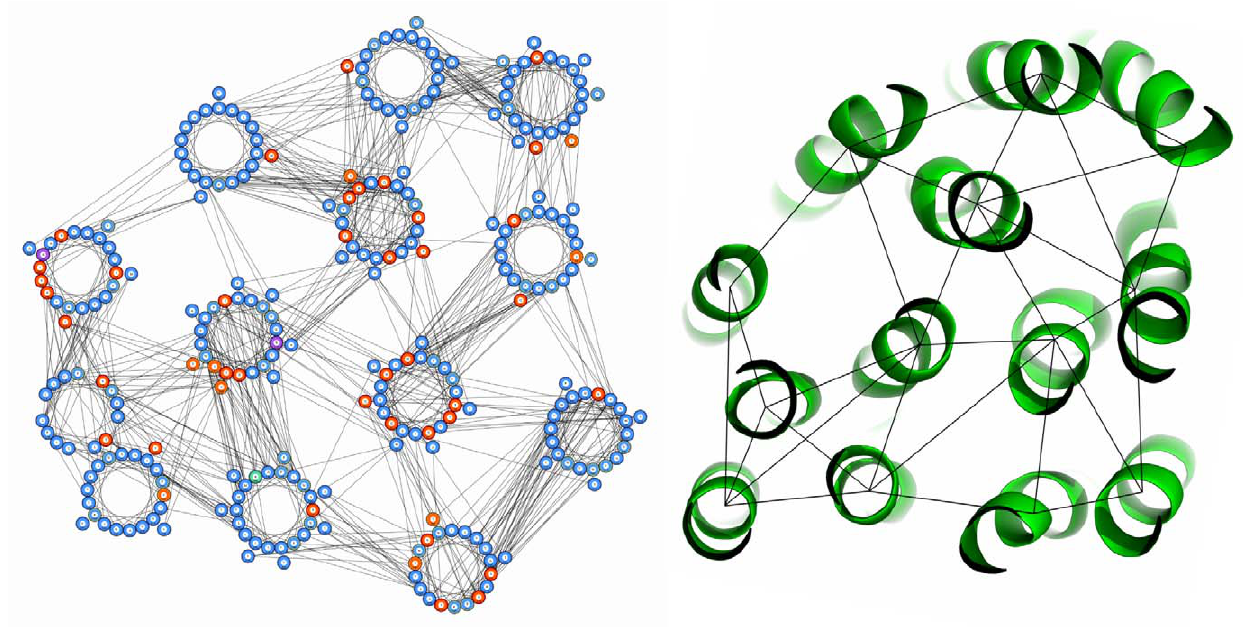
Figure 3. Helical packing arrangement and crystal structure of cytochrome C oxidase (1XME:A), generated using observed rather than predicted helix-helix interactions. Observed residue-residue contacts are annotated on the packing arrangement while observed helix- helix interactions are annotated on the crystal structure. In this example, the two helices at the bottom left of the arrangement are incorrectly placed; they share the same helix-helix interactions but the correct arrangement has one same-side loop crossover whereas the incorrect arrangement has none. The alternative correct arrangement where the placement of these two helices is reversed is returned as the second highest scoring arrangement.